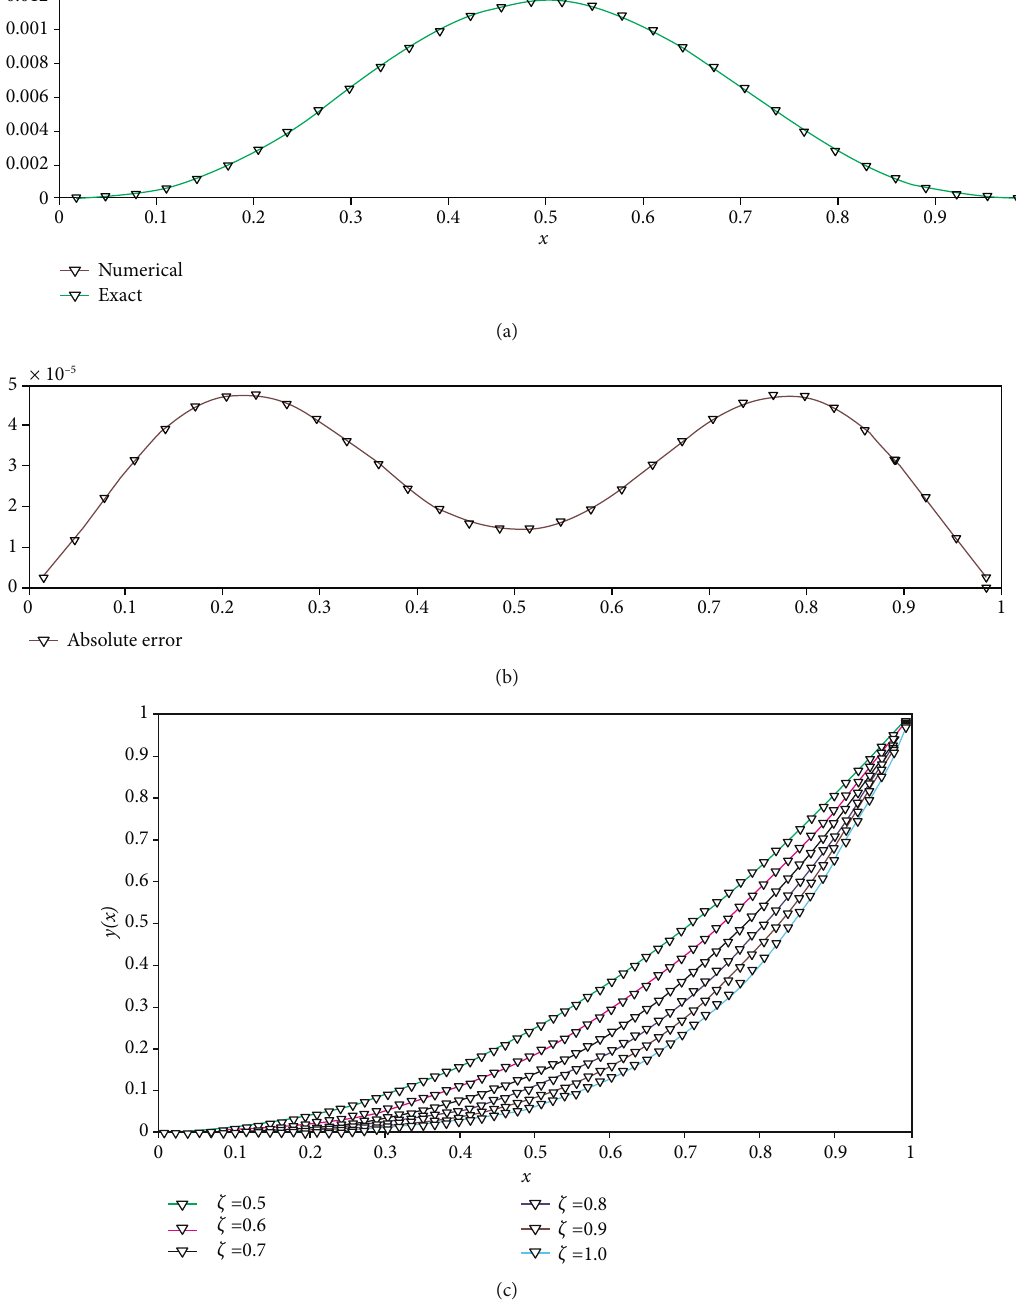
Figure 3: (a) Approximate and exact solutions of equation (57) for ρ = 0 : 6 and φ ð ζ Þ = ζ 2 − ζ : (b) Maximum absolute error. (c) Approximate solutions of equation (57) for φ ð ζ Þ = ζ 2 and various choices of ρ